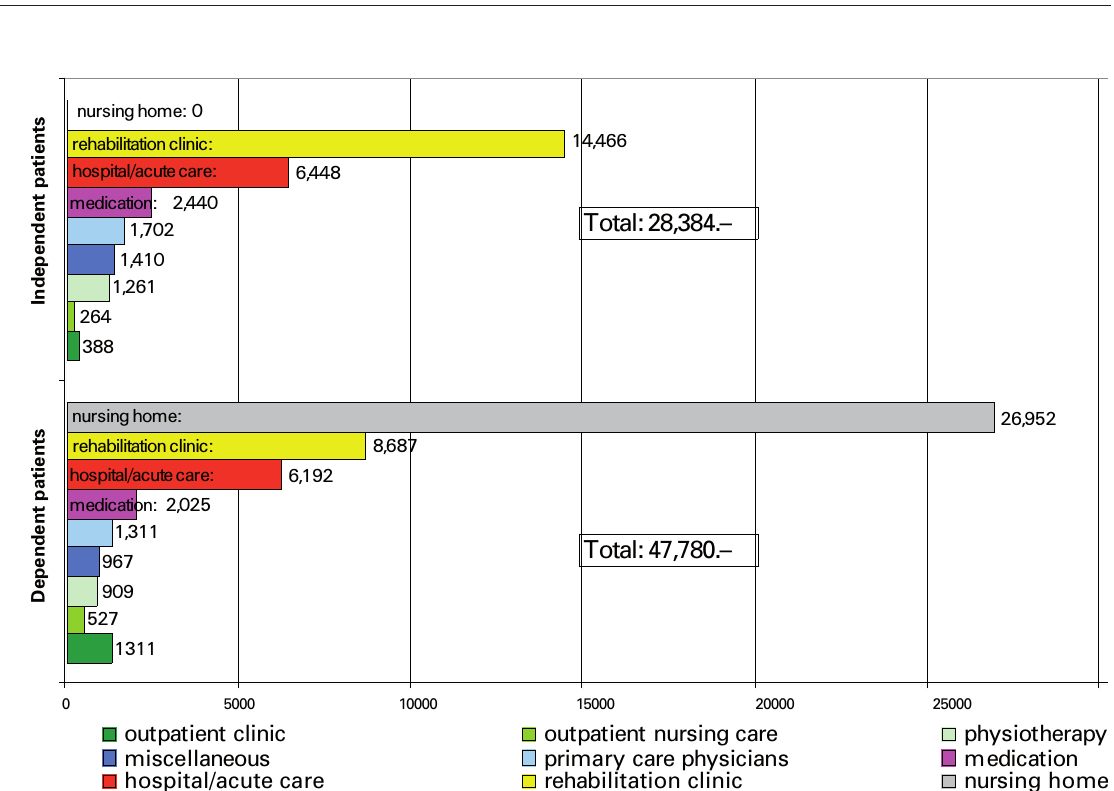
The costs are given according to the insti- tutions: The three largest sums are: 1. the inpatient reha- bilitation, 2. the long- term costs of the nursing homes and 3. the acute hospital. The out patient care by general practition- ers comprises 5% and appears rela- tively modest. Total costs of the first year include 31,115 ± 23,752 CHF.